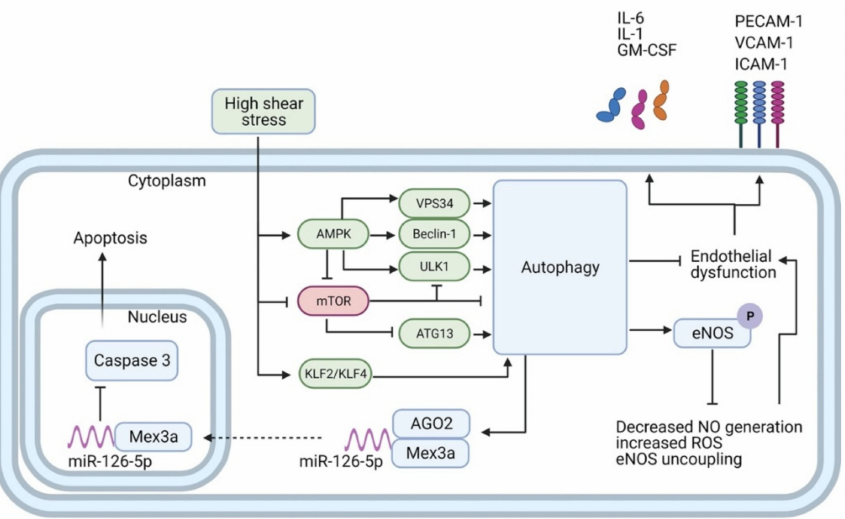
Figure 2. Autophagy transduces the effects of high-shear stress (HSS) in endothelial cells. HSS pro- motes autophagy through the activation of AMPK, KLF2, and KLF4, along with the suppression of mTORC1. AMPK in turn directly activates VPS34, Beclin-1, and UKL1, and represses